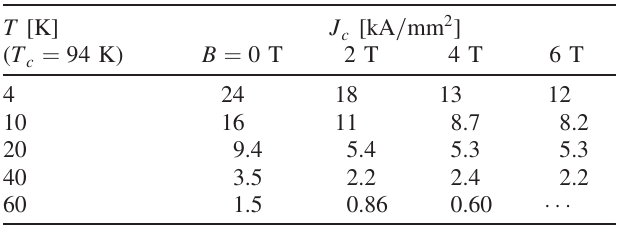
TABLE I. Critical current density of QMG-GdBCO under magnetic field. Measurements were carried out by the dc magnetization method with a small sample ( ∼ 0 . 2 mm 3 ).